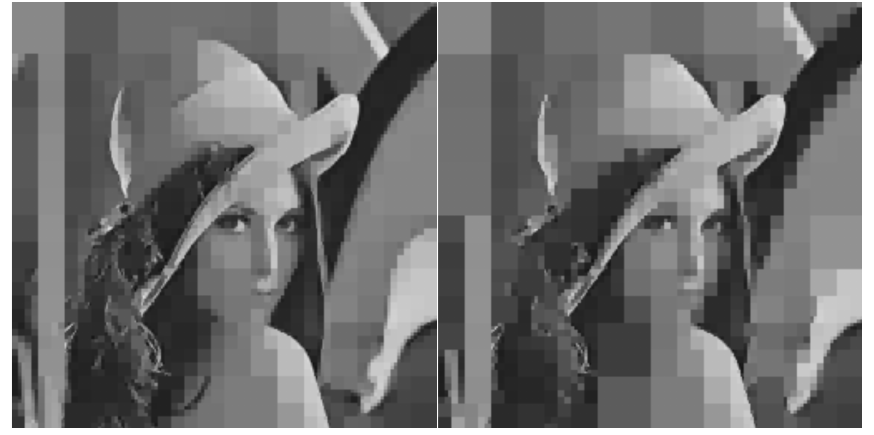
Figure 18 . Initial Transmitted Image Frame ( t = 0 s—left side)—Converged Transmitted Image Frame ( t = 400 s—right